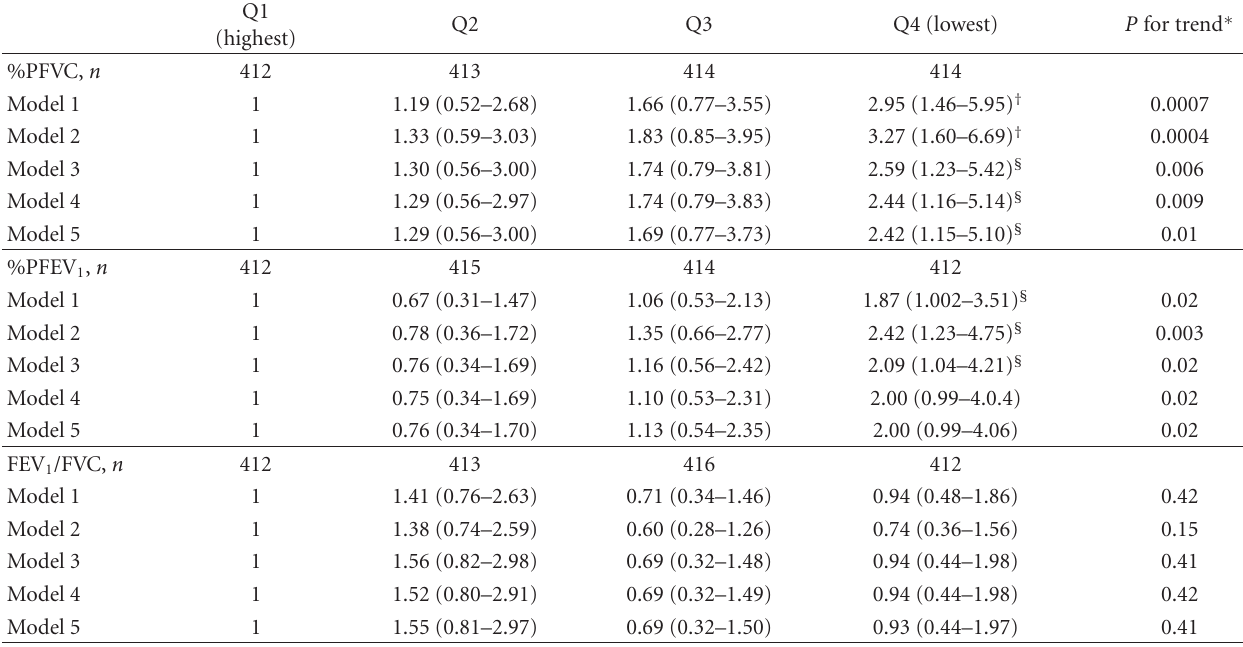
Table 2: Odds ratio (95% CI) of lung function quartiles for ST-T